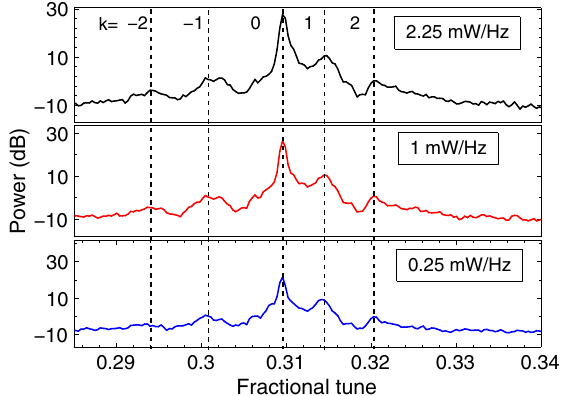
FIG. 17. Tune spectra at 5 (cid:7) 10 8 U 73 þ particles with beam excited at three different excitation amplitudes. The beam is excited with 0.25, 1.0, and 2 : 25 mW = Hz power (blue, red, and black, respectively). The dotted lines mark the relative positions of the head-tail modes. The frequencies of various head-tail modes are unaffected.